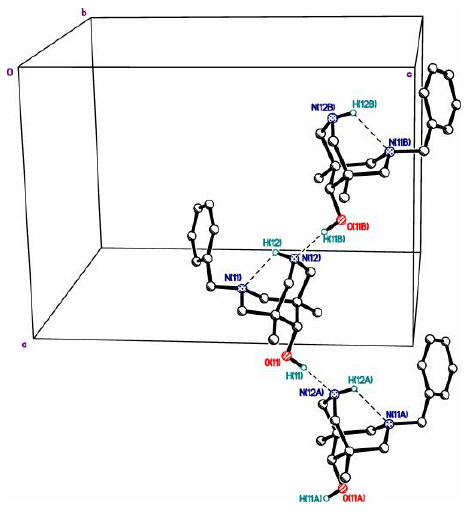
Figure 3. Hydrogen-bonded chains in structure 3a